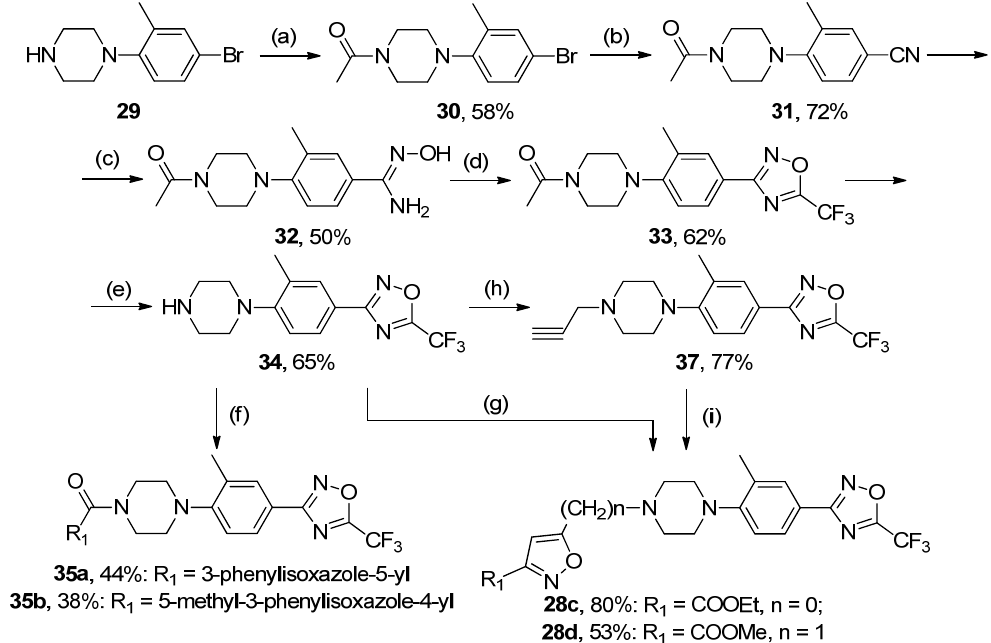
Scheme 5. Synthesis of piperazine derivatives 35a,b , 28c,d . (a) Ac 2 O, 65 ◦ C; (b) CuCN,